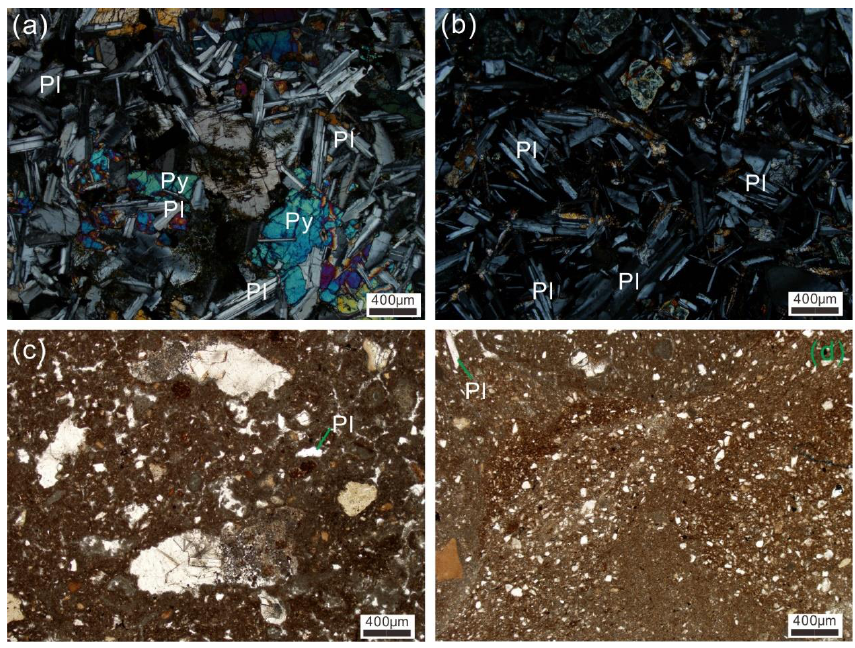
Figure 3. Photomicrographs of volcanic rocks from the Jiangling Basin. Py-pyroxene, Pl-plagioclase. ( a ) intergranular basalt. Olivine undergoes intense alteration, chloritization, and iddingsitization; perpendicular polarized light. Plagioclase is colorless and transparent and has two groups of com- plete cleavage; long strip, polarization microscope common twin, interference color level gray, neg- ative low protrusion. ( b ) Basalt is mainly composed of plagioclase (Pl) and pyroxene (Py), with weak alteration pairs; perpendicular polarized light. Pyroxene is the most common mineral in ultrabasic rocks and mafic rocks. It is greenish black and has two groups of nearly vertical cleavage, often forming irregular stepped fractures. ( c ) plane polarized light of ( a ). ( d ) plane polarized light of ( b ). 3. Sampling and Analytical Methods We selected the freshest Paleogene volcanic samples (n = 21) for whole-rock geo- chemical analysis. Each sample was carefully cleaned, crushed, and then ground in an agate mortar to pass through a 200-mesh screen. The major elements were determined on fused glass beads via X-ray fluorescence (XRF) spectrometry. The analyses were per- formed in the National Research Center for Geoanalysis of Chinese Academy of Geologi- cal Sciences. The analytical accuracy was estimated at 1% for SiO 2 and 2% for the other oxides. Trace elements, including rare earth elements (REE) and high field strength ele- ments (HFSE), were determined by inductively coupled plasma-mass spectrometry (ICP- MS). The analyses were performed in the National Research Center for Geoanalysis of Chinese Academy of Geological Sciences. Two national standards (GSR3 and GSR5) and three internal standards were measured simultaneously to ensure the consistency of the analytical results. Analytical uncertainties were estimated at approximately 10% and 5% for trace elements with abundances of <10 ppm and >10 ppm, respectively. Water and CO 2 contents were determined by gravimetric techniques in which the sample was heated in a closed container and the water vapor was collected in a separate tube, condensed and then weighed — the detection limit for H 2 O and CO 2 was 0.01 wt.%. To precisely constrain the formation age of the volcanic rocks, we performed 40 Ar/ 39 Ar stepwise laser heating experiments. Selected samples (n = 9) were purified and crushed, repeatedly sieved to uniform mineral grains of 0.5 – 2 mm, washed in an ultra- sonic bath of distilled water for 1 h, and then dried. The argon isotopes were analyzed on